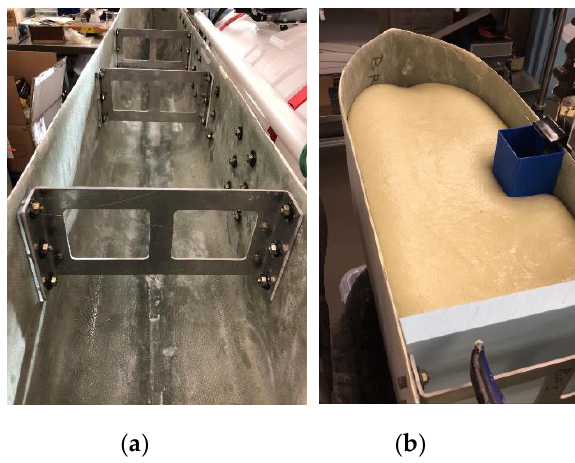
Figure 7. Aluminum struts bolted within the pontoons for enhanced lateral support: ( a ) before foam filling); ( b ) urethane foam filling process.